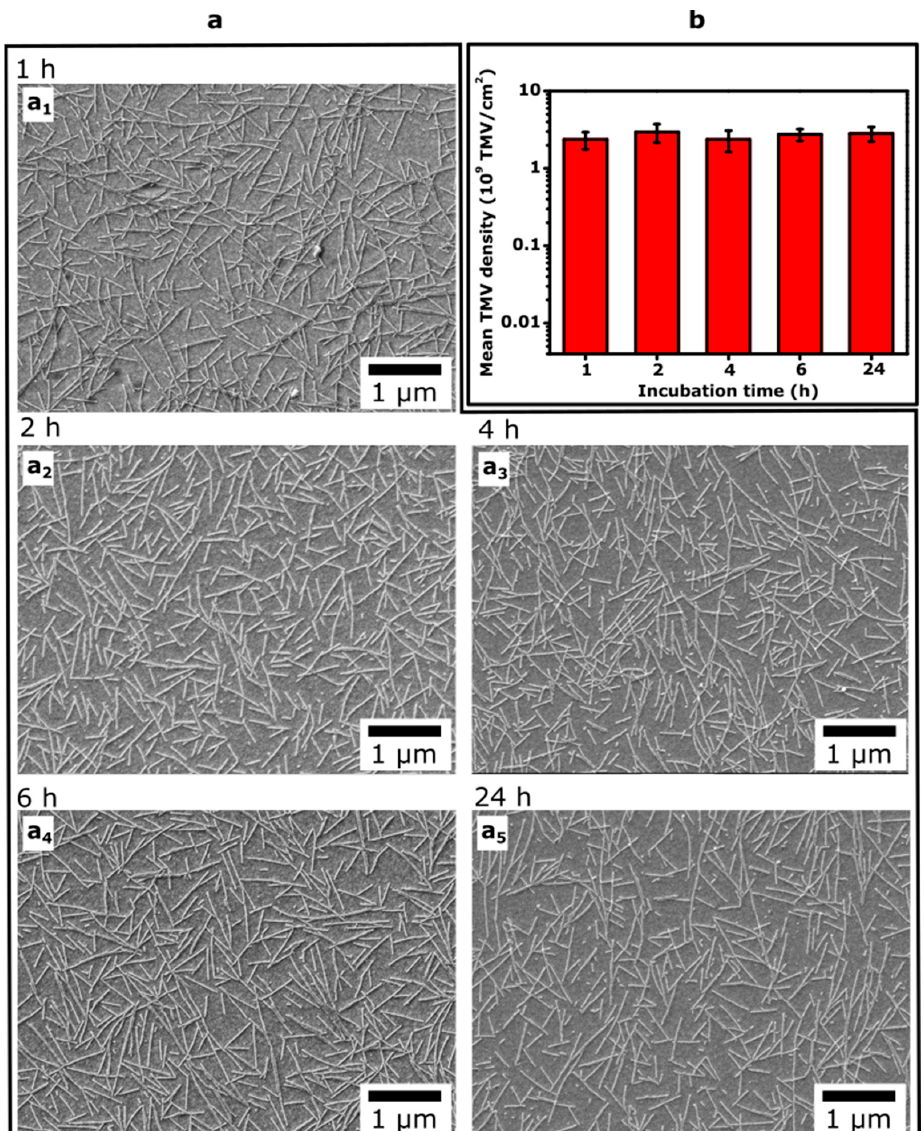
Figure 6. ( a ) SEM images taken from Ta 2 O 5 surfaces after incubation of EIS chips with 0.1 µg/µL TMV solution for 1 h, 2 h, 4 h, 6 h, and 24 h ( a 1 – a 5 ); ( b ) Mean density of TMV particles on Ta 2 O 5 surfaces evaluated from SEM images. For each incubation time, three EIS chips were characterized ( n = 3).